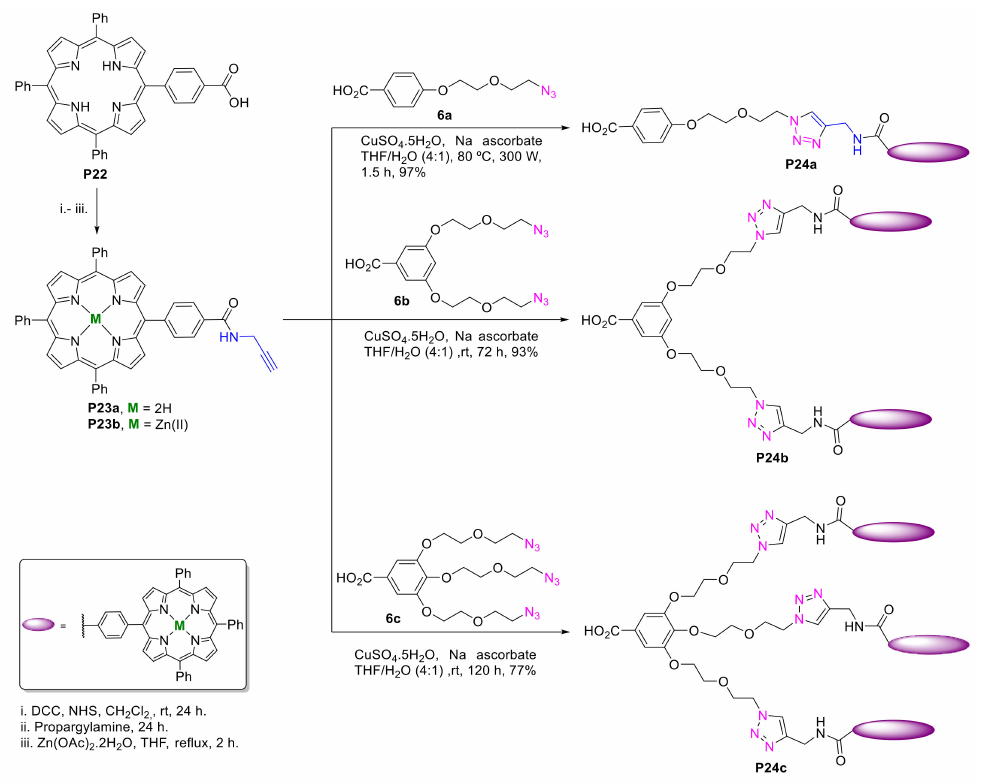
Figure 1. Structure of trimeric porphyrin—dendritic derivative P21